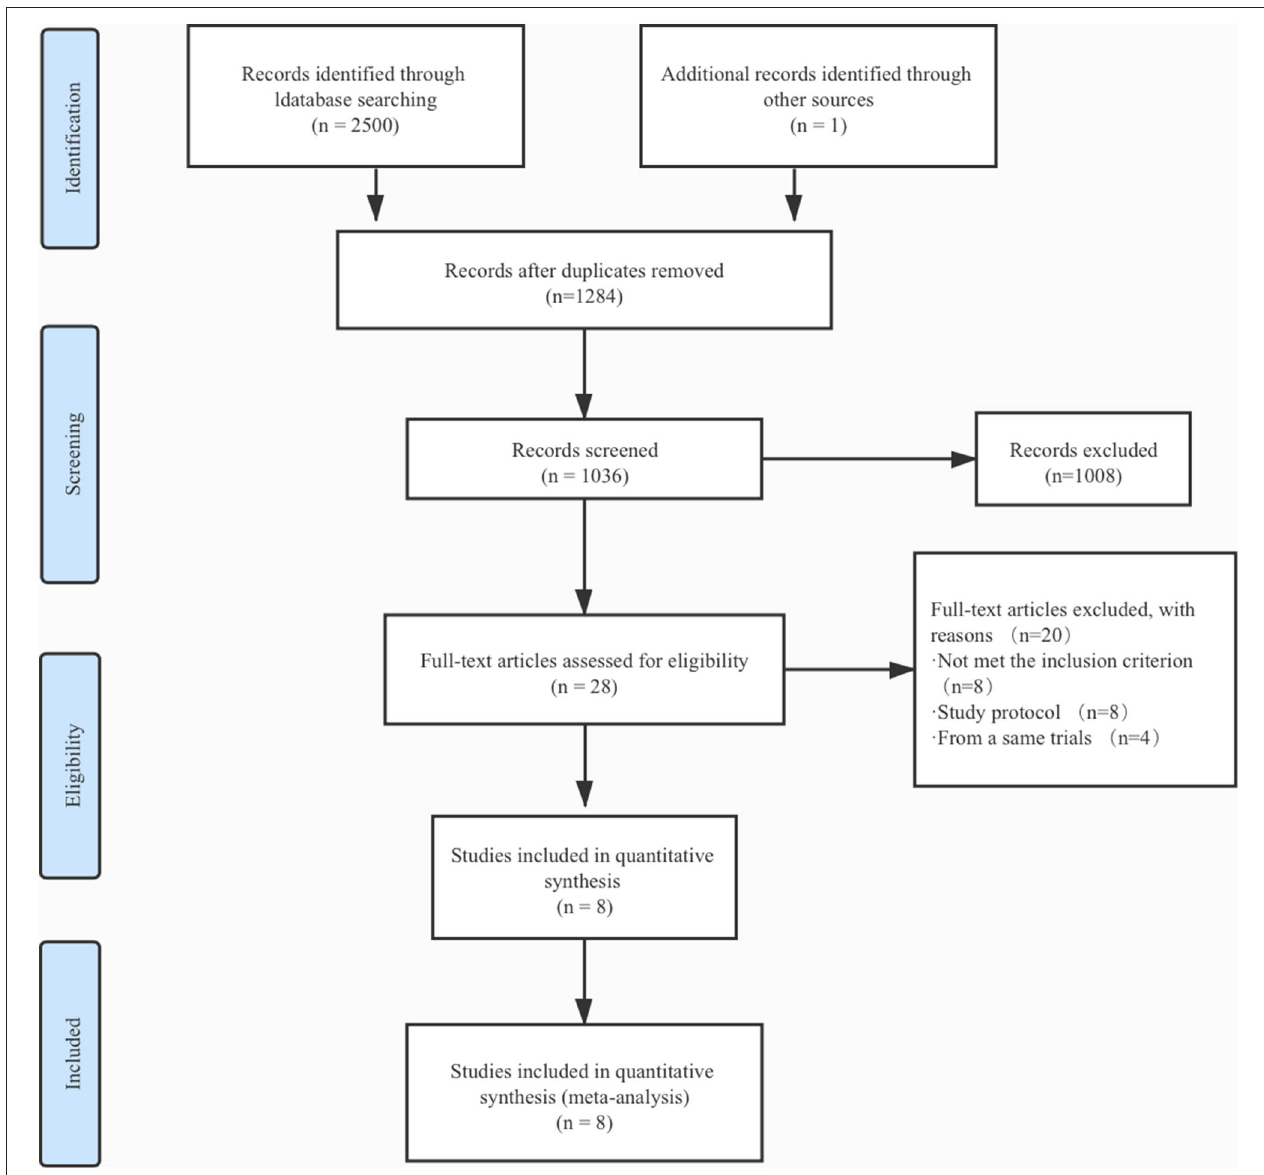
FIGURE 1 | Flow diagram of literature